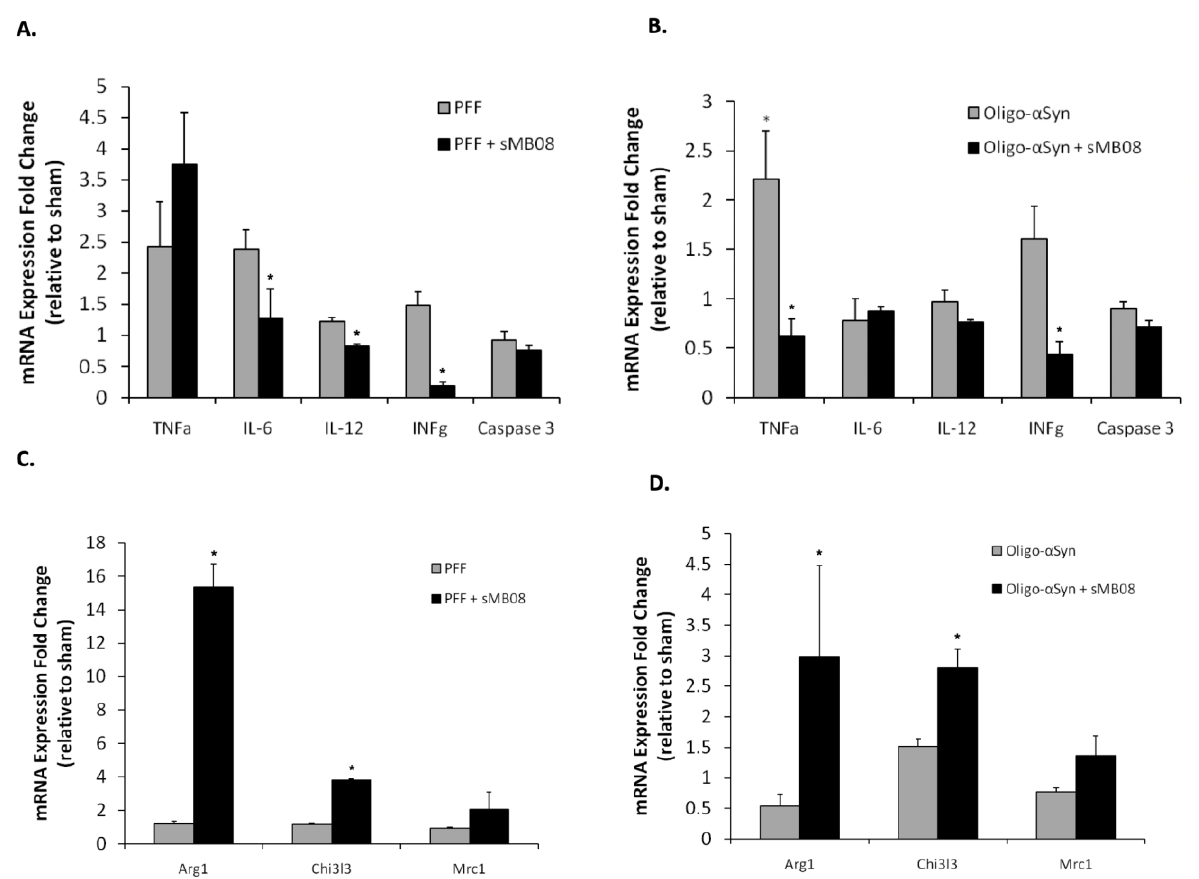
Figure 4. The effect of sMB08 on neuroinflammation in mice stererotactically injected with mis aSyn. Graphs showing that sMB08 attenuates neuroinflammation in murine cortex of animals injected (striatum) with PFF ( A , C ) and oligomers ( B , D ). Real-time PCR was done in brain cortical homogenates. The expression of TNFa, IL-6, IL-12, INF γ , Caspase 3, Arg1, Chi3l3, and Mrc1 was determined by TaqMan real-time PCR in brain homogenates. The y -axis represents the fold-change in expression after PFF intrastriatal injections (with and without sMB08 treatment). GAPDH was used as “housekeeping” gene. * p < 0.05. Error bars represent standard error of the mean.